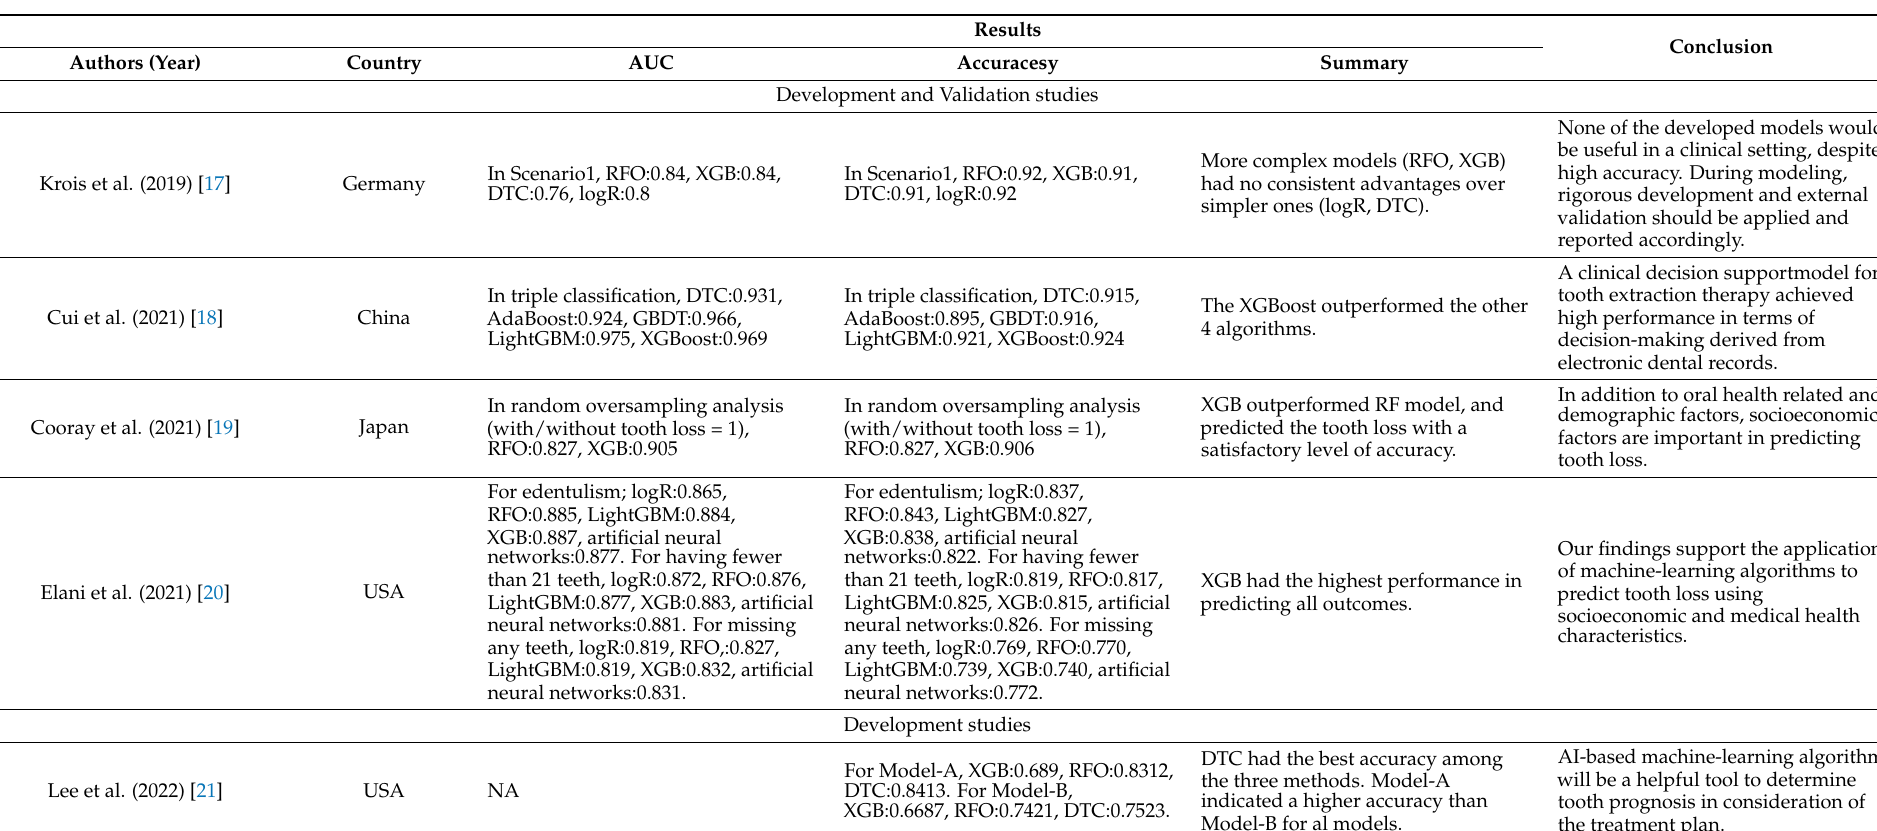
Table 2. Main results and conclusions of included